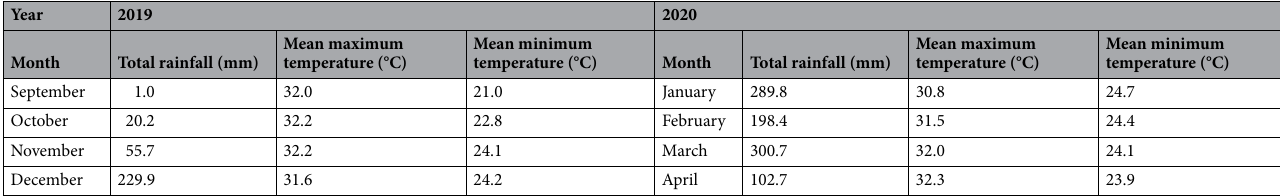
Table 1. Total monthly rainfall and mean maximum and minimum temperature of the test site during 2019 and